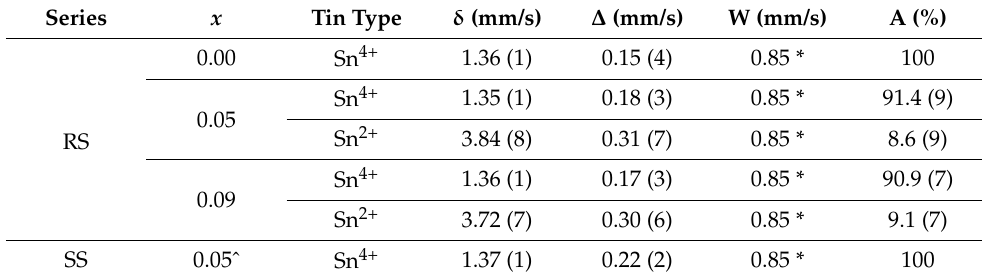
p -type semiconductor, this phenomenon would contradict the theory. If the SS samples of Cs 2 Sn 1-x Ga x I 6-x are n-conductive, as reported by most authors, the Ga 3+ atoms will serve as electron traps or increase the e’-h˙ recombination probability. SS series. Most likely, most of the spectra correspond to the superposition of subspectra